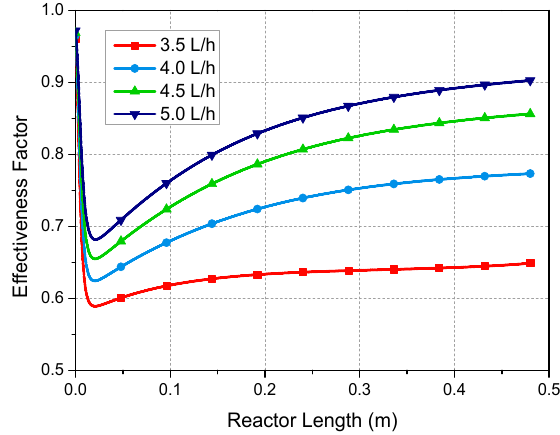
Figure 6. Effective factor of MSR reaction along the length of reactor with the inlet flow rate of fuel ranging from 3.5 to 5.0 L/h. The particle size of catalyst is 1.5 mm.